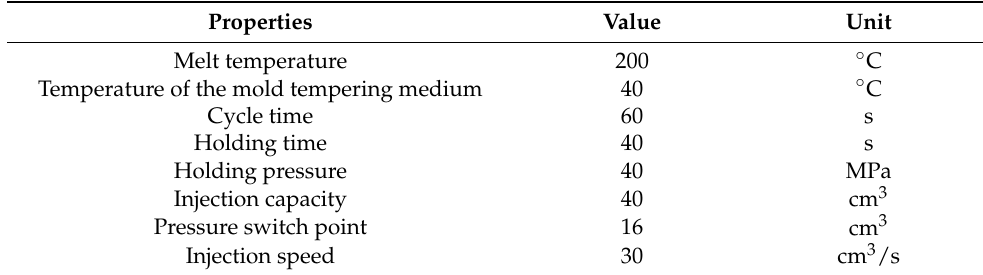
Table 4. Technological conditions for injecting test